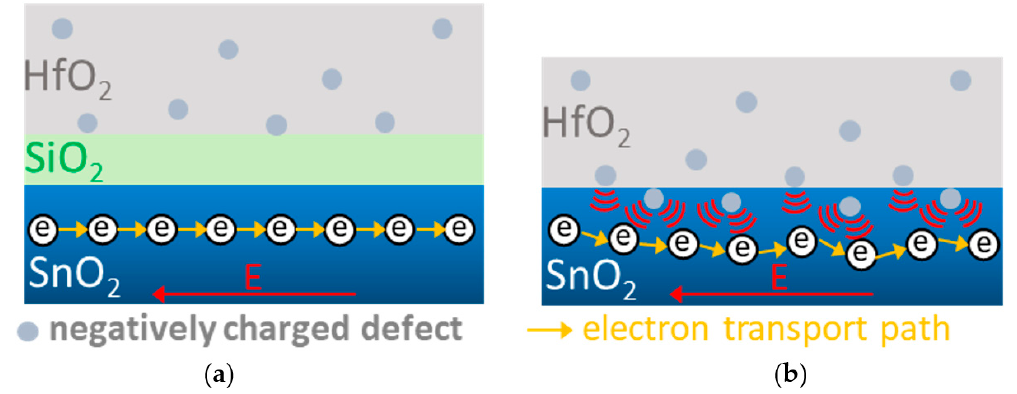
Figure 5. The schematic diagrams for electron transport in ( a ) with ( b ) without an SiO 2 interfacial layer. Negative charges formed in HfO 2 for a device without an SiO 2 layer will increase the electron scattering and lower the mobility.